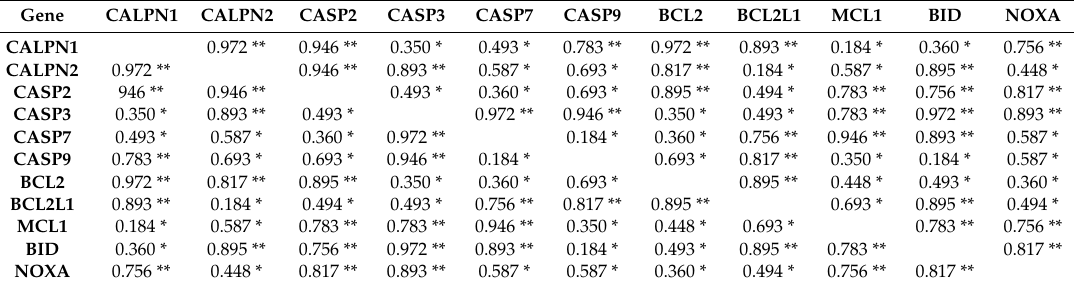
Table 4. Correlation analysis of apoptosis related-genes in the heart of chicken. Gene CALPN1